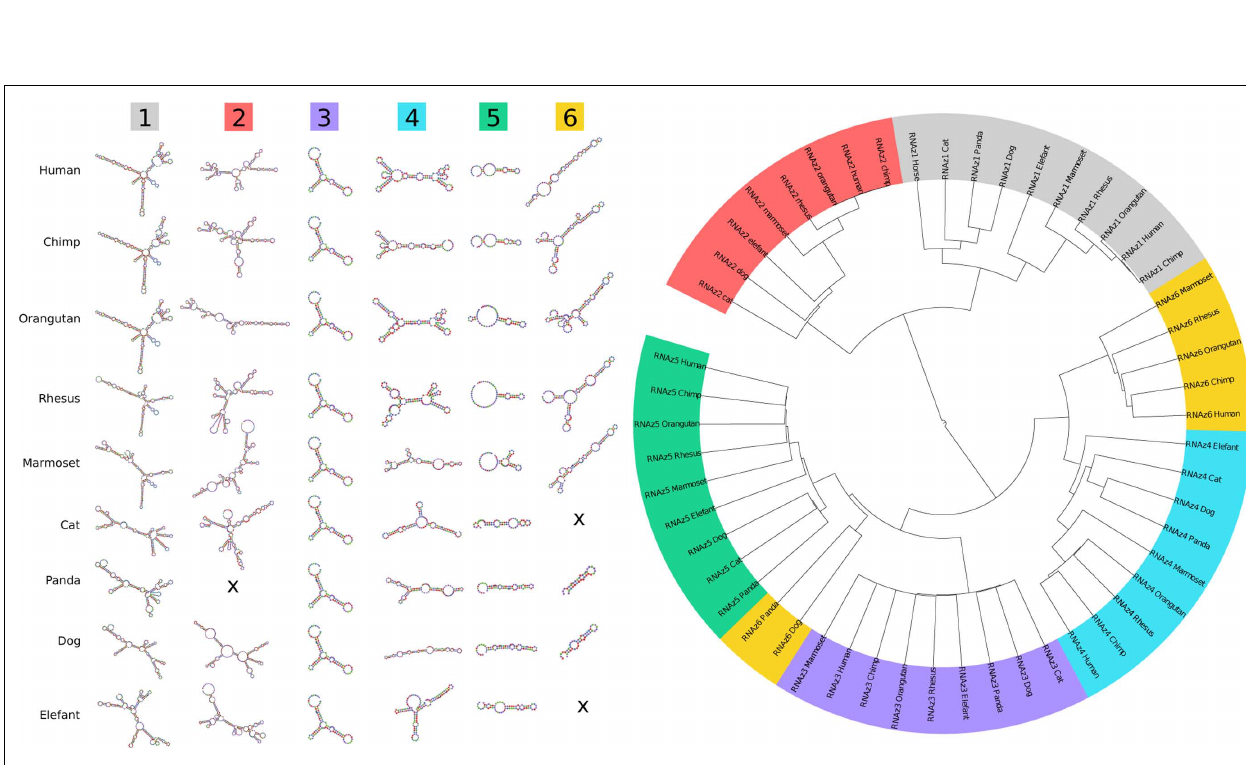
sequence/structure-based clustering using LocARNA (Will et al., 2007) visualizes the similarities between the predicted structures in more detail. As expected, the structures nearly perfectly cluster into the six